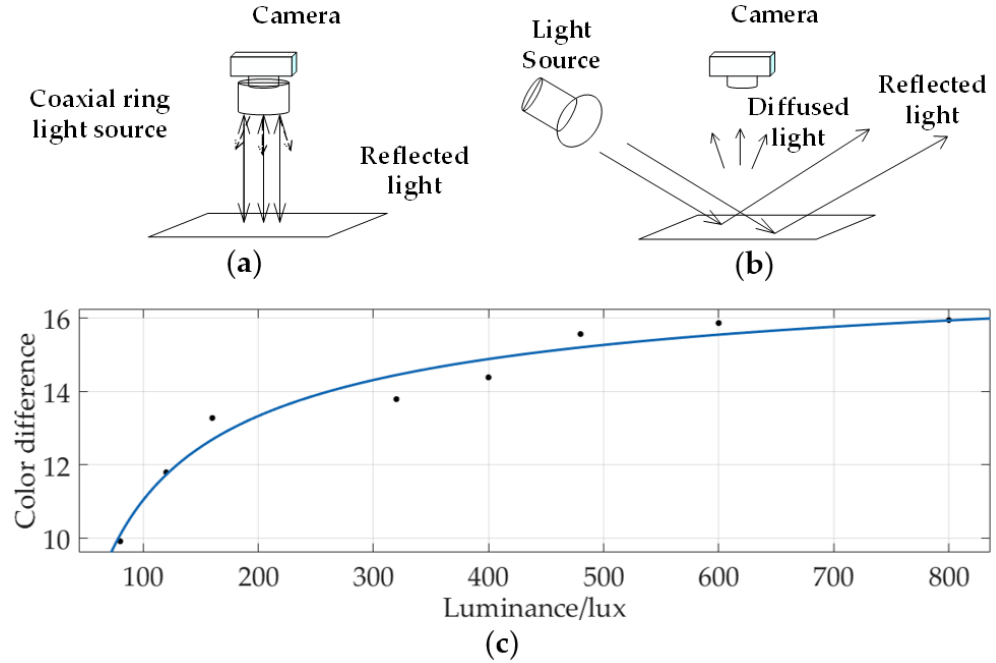
Figure 6. Sketch map of lighting system and the relationship of color di ff erence and environment illuminance. ( a ) The lighting system using the coaxial ring light source; ( b ) the lighting system using the scattered light source; ( c ) the fitting curve of color di ff erence changing with luminance.